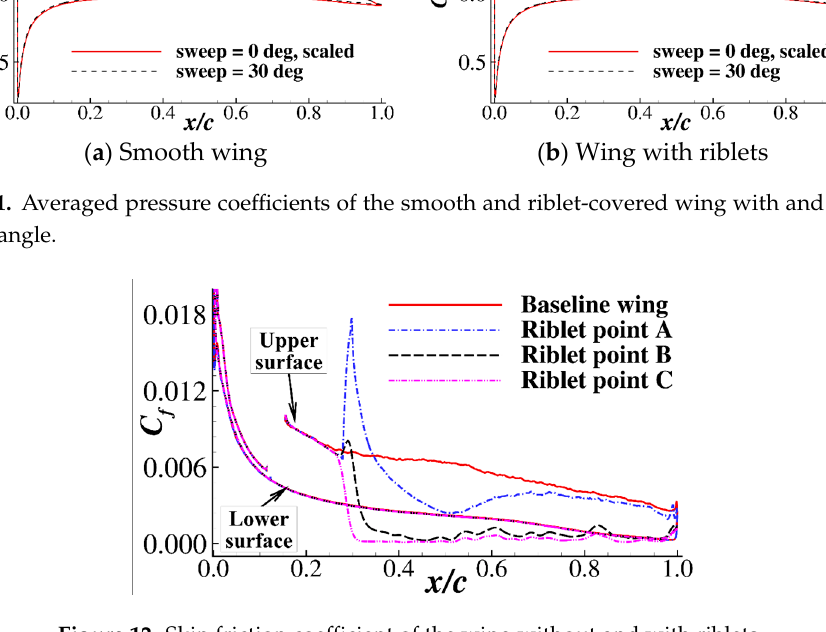
Figure 12. Skin friction coefficient of the wing without and with riblets.